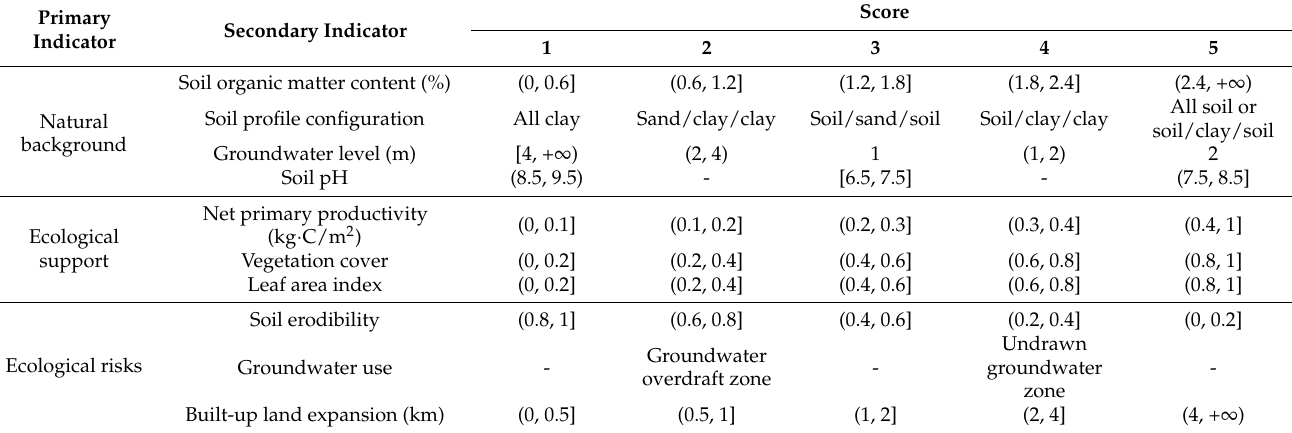
Table 1. Yuanyang County cultivated land ecological security evaluation index